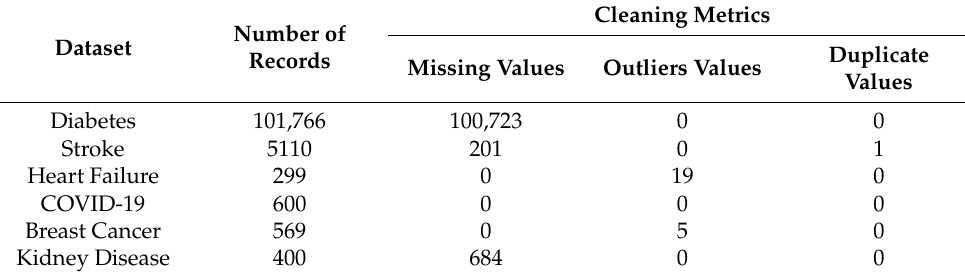
Table 7. Cleaning results for each use case.